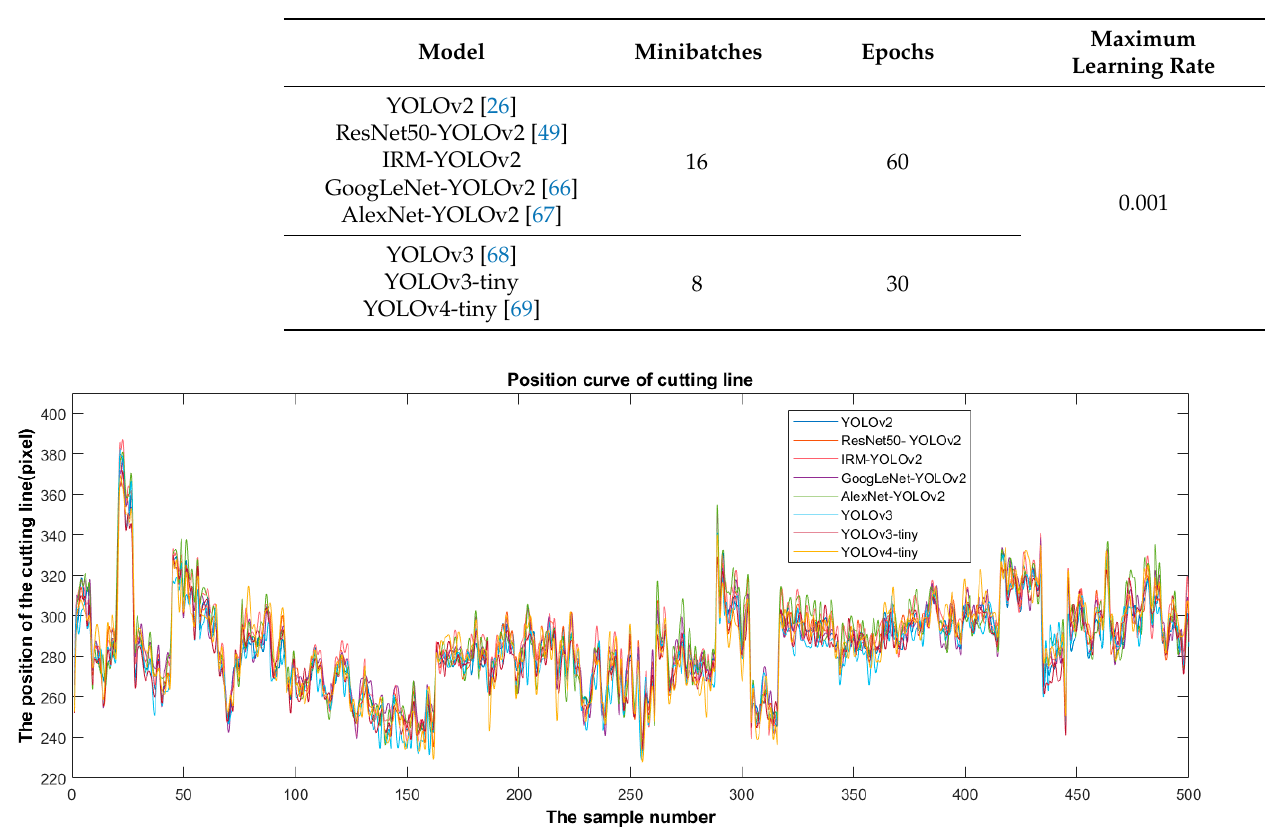
12 of 20 Table 1. Configuration of the proposed detector model. Model Minibatches Epochs